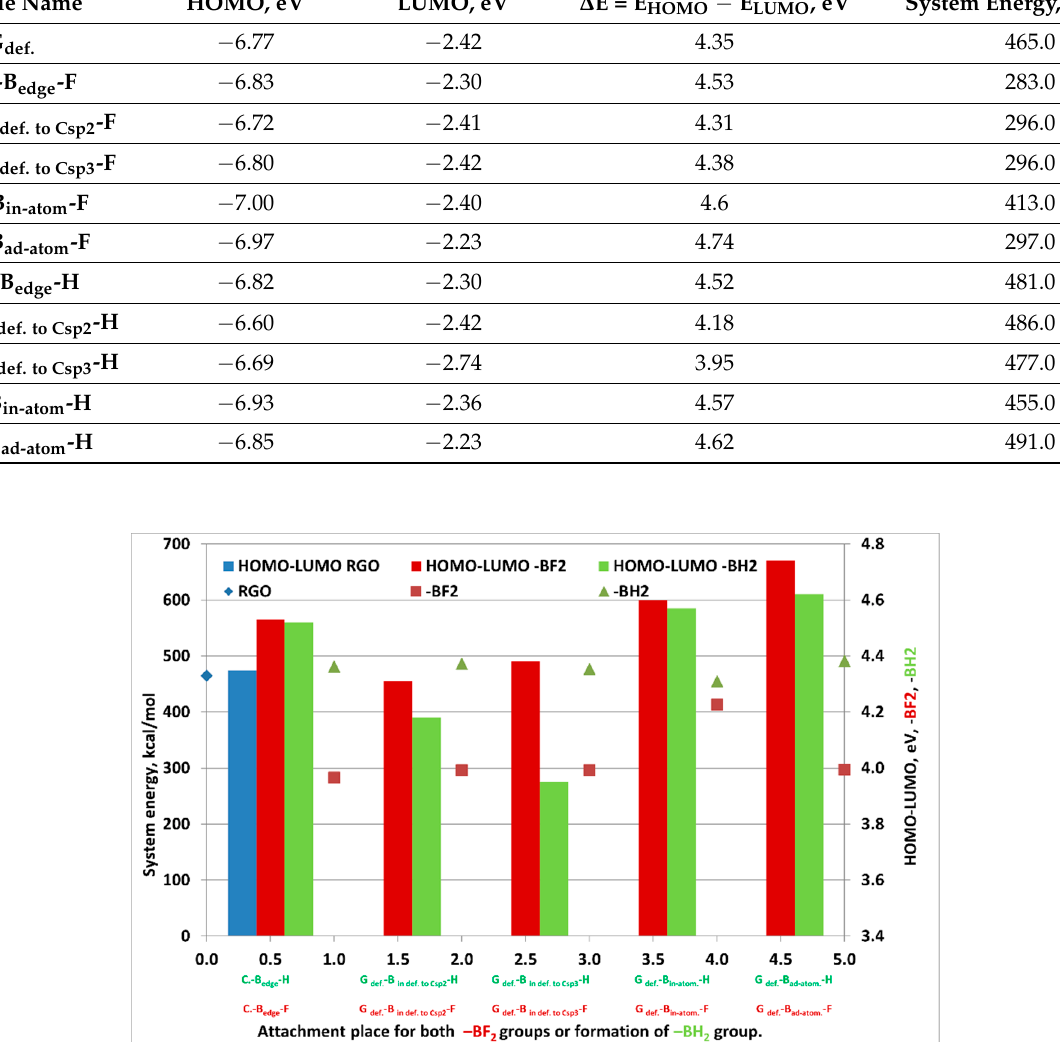
Table 3. Highest (HOMO) and Lowest (LUMO) Occupied Molecular Orbital analysis and the energy of graphene systems depending on the place of attachment of -BF 2 groups or formation of -BH 2 groups, respectively: on the edge of the flake (a), in the area of the defect in the form of vacancy 1 C to carbon with sp 2 (b) or sp 3 hybridization (c), either atomically for the sp 3 hybridized carbon of the graphene structure (d) or adatomically (e) with respect to an unmodified, defective graphene flake.